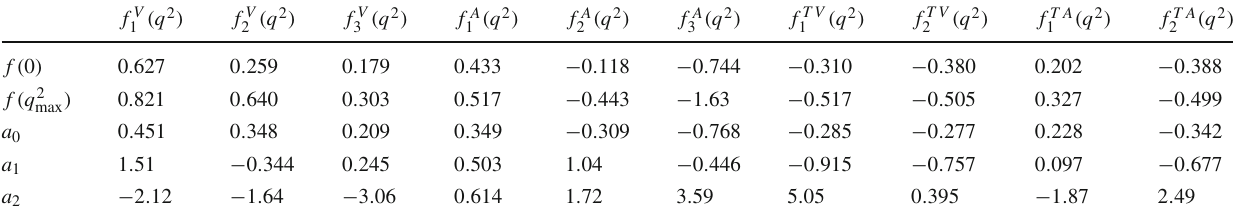
. The fitted values of the parameters a 0 , a 1 , a 2 GeV for f A 3